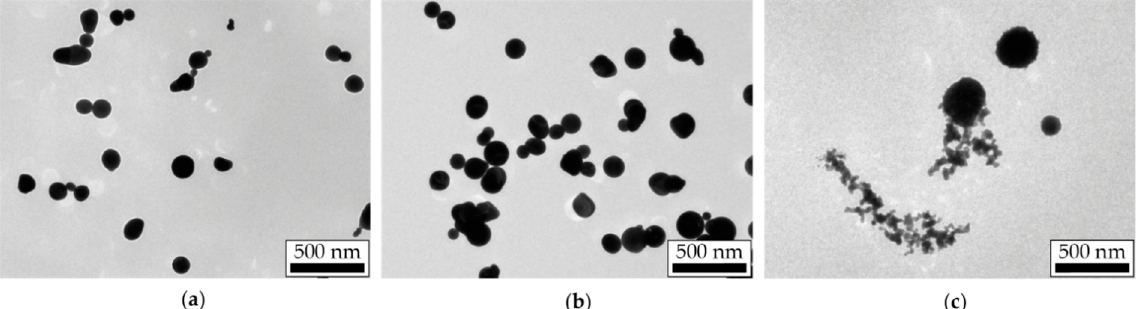
Figure 5. TEM images of Pt ( a ), Au ( b ) and Ag ( c ) NPs agglomerates, modified by laser radiation with the wavelength of 1053 nm at the maximum pulse energy density and pulse repetition rate of 500 Hz for the aerosol flow rate 50